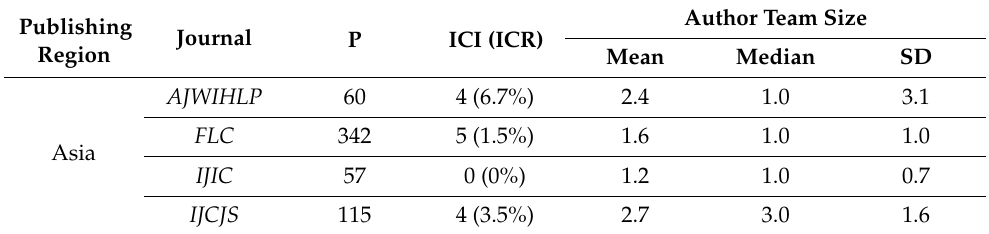
Table 6. Authorship of Asian Law Journals Published in Asia and Western